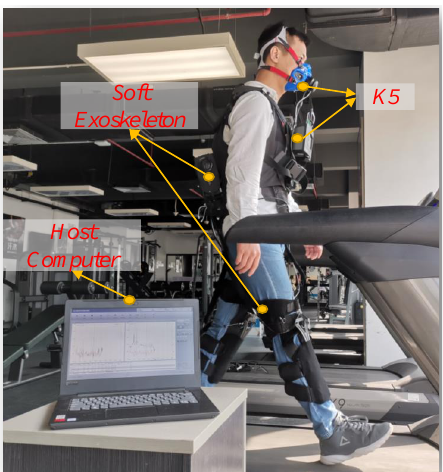
Figure 10. While a subject is walking with the soft exoskeleton, an actuator-driven Bowden cable is used to generate assistance in the lower limb. The metabolic rate is measured through K5.